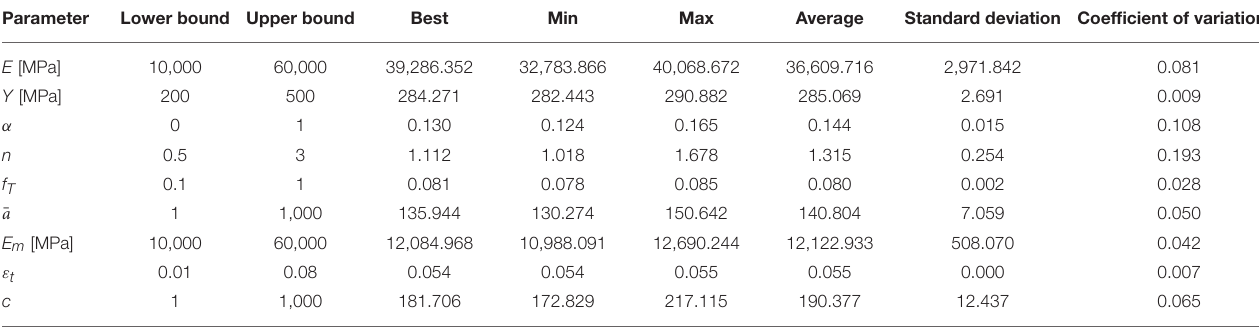
TABLE 4 | Statistical analysis of identified parameters of the proposed model for the experimental data obtained from Ozbulut et al. (2010) shown in Figure 5D . Parameter Lower bound Upper bound